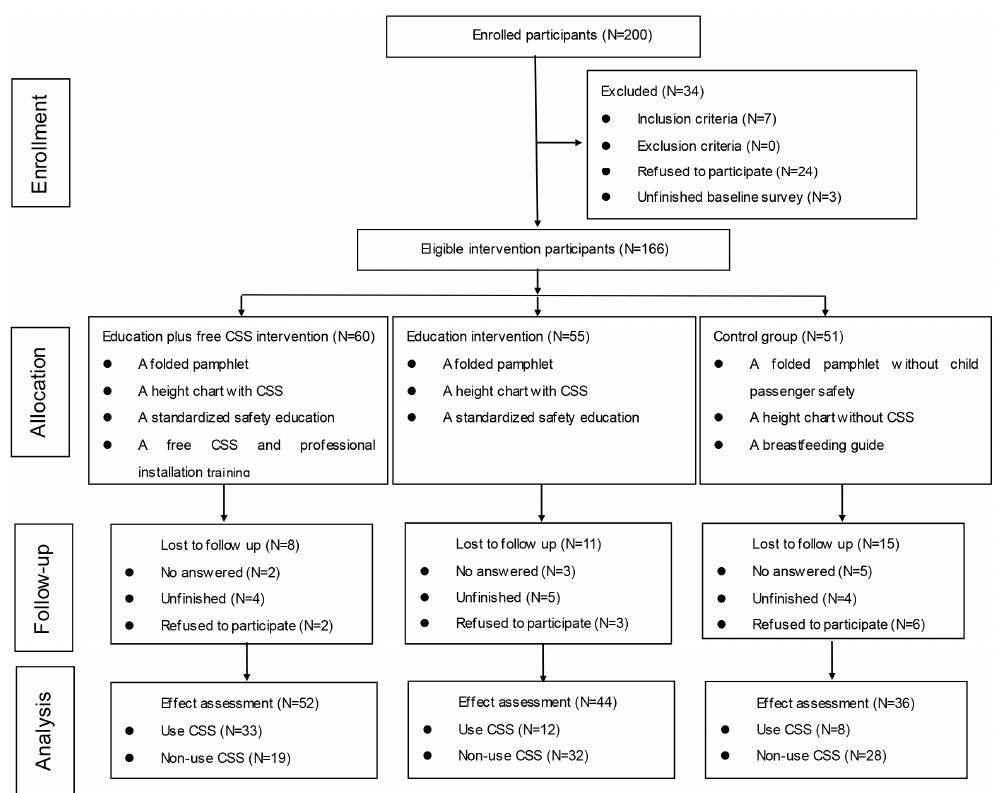
Figure 1. Study procedures.